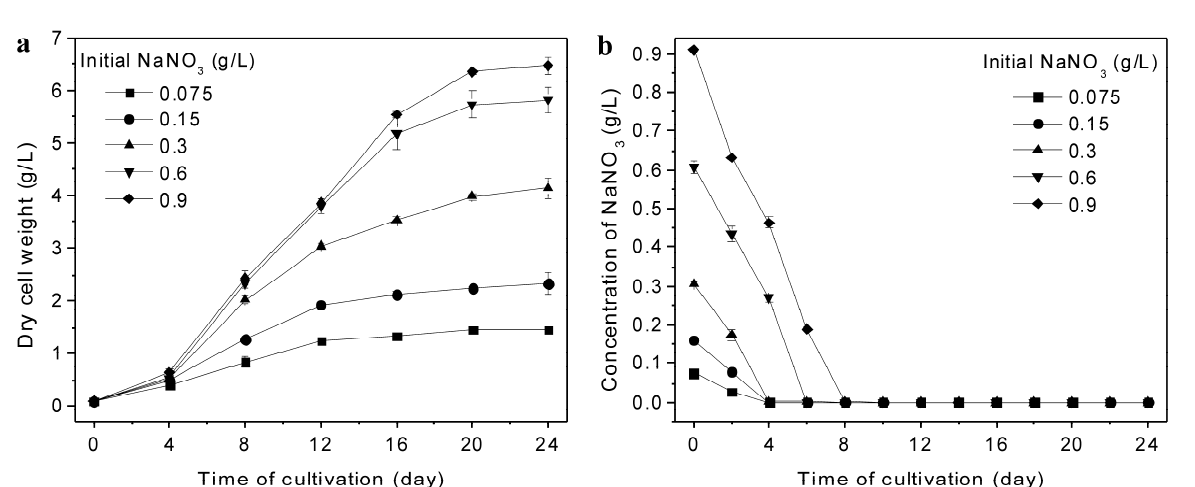
Figure 5. Growth curves ( a ) and nitrogen consumption ( b ) of Coelastrum sp. HA-1 at different initial NaNO 3